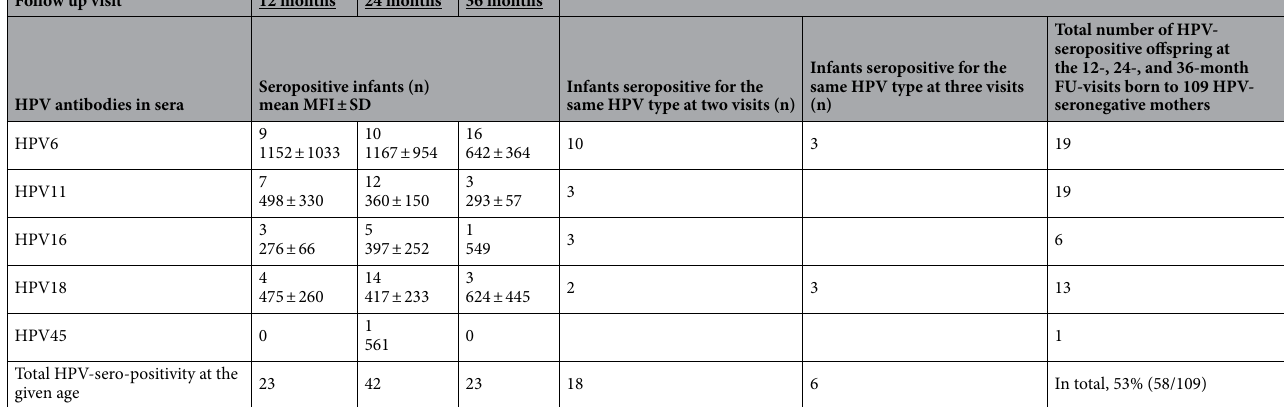
Table 2. Human papillomavirus (HPV) seroprevalence to HPV-genotype 6, 11, 16, 18 and 45 in the offspring at the age of 12-, 24, and 36 months born to the mothers seronegative for the respective HPV-genotype. The cut-off for seropositivity was ≥ 200